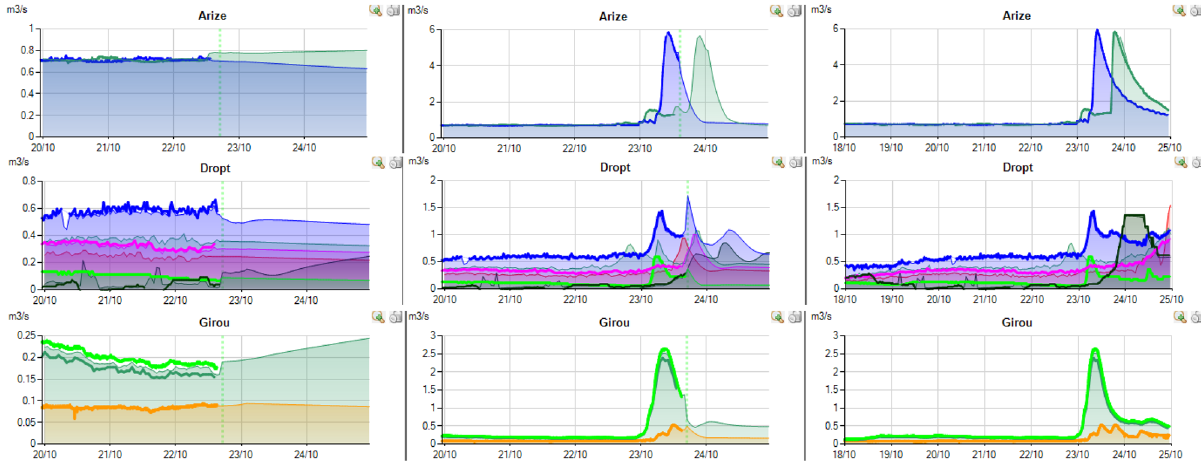
Figure 13. Right tributaries of the Garonne dashboards